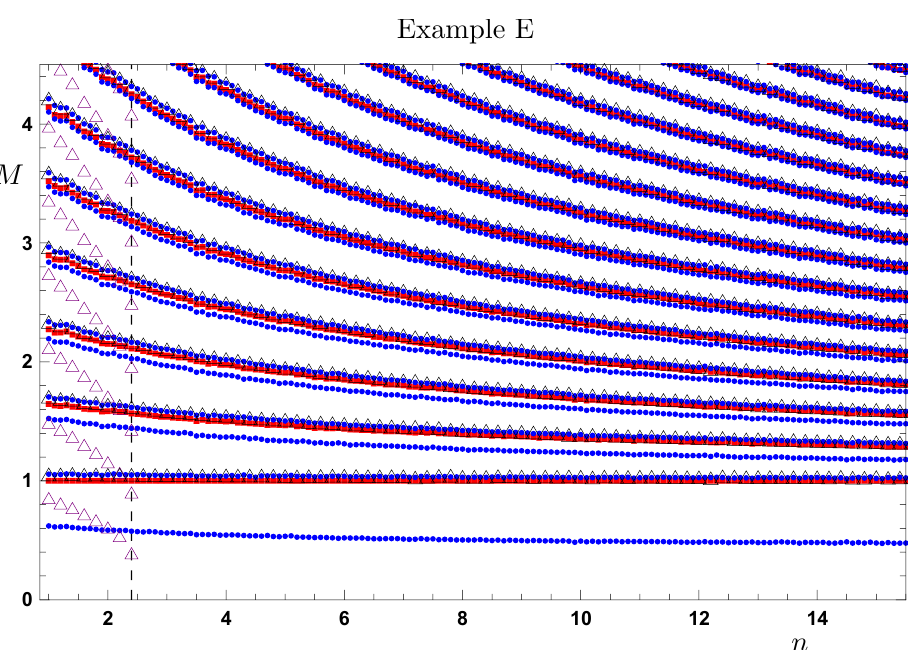
p Figure 6 . Masses M = (cid:0) q 2 of modes in the toroidal reduction from D = 5 + n dimensional gravity with a negative cosmological constant, as a function of the parameter n . The (cid:12)ve dimensional action we use can be obtained from toroidal compacti(cid:12)cation of higher-dimensional gravity theories only for integer n > 1, but we analytically continue our study to model for all values of n (cid:21) 1. All masses are expressed in units of the mass of the lightest tensor mode. The (red) squares represent the tensor modes, the (blue) circles are the scalar modes, computed with the complete, gauge- invariant variables, while the (black) triangles are the scalar modes computed by making use of the probe approximation, in the case of the (cid:13)uctuations of the (cid:12)eld ! . For the probe